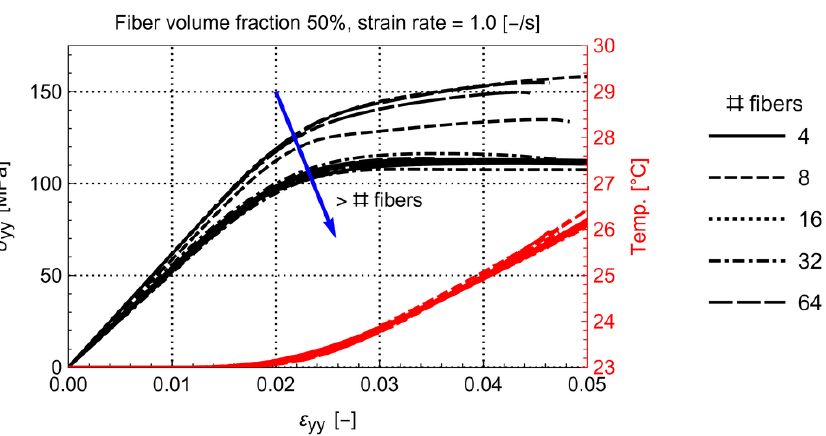
Figure 4. Homogenized stress-strain response for the models with 50% volume fraction and different amounts and arrangements of fibers.